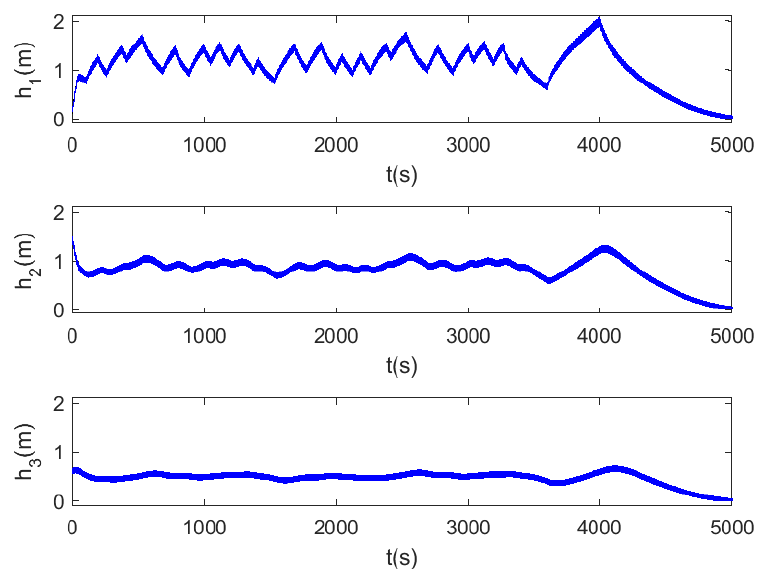
10 of 15 Figure 4. Schematic representation of the extended three-tank system.